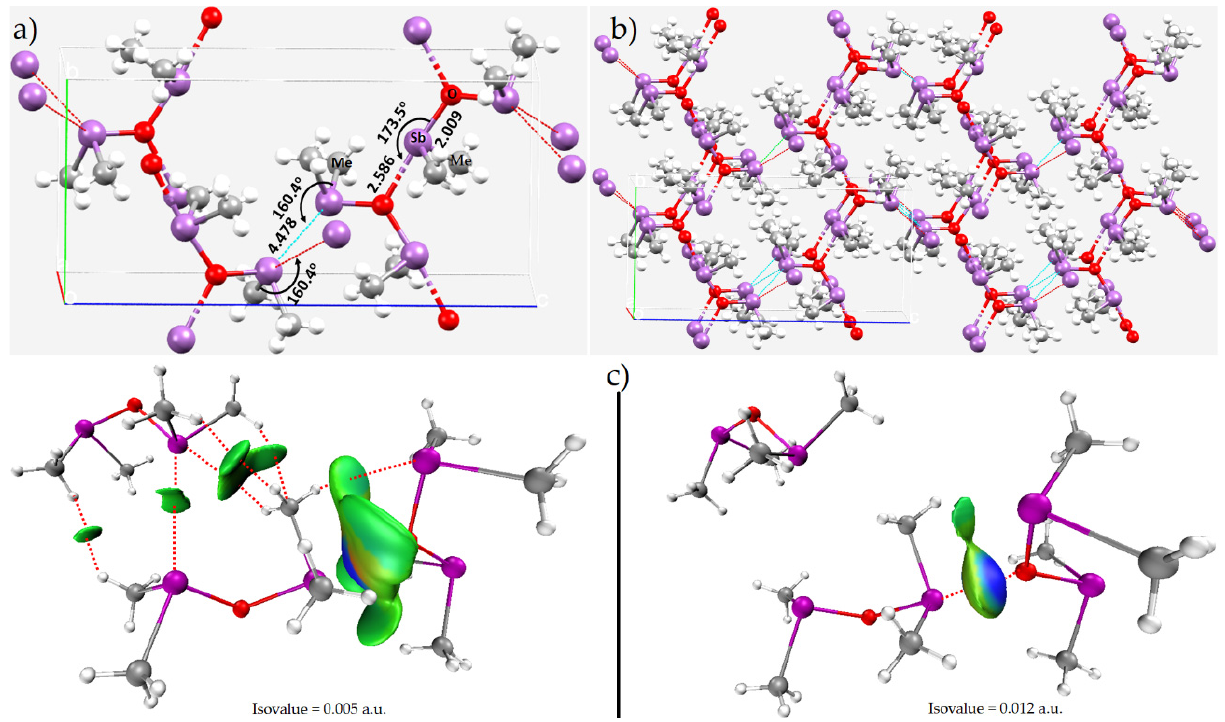
Figure 13. ( a ) Selected intermolecular bonding interactions in the crystal structure of bis(dimethylstibanyl)oxane, ((CH 3 ) 2 Sb) 2 O, CSD ref. code MELNAS. ( b ) The 2 × 2 extended structure of the unit-cell of the crystal, showing the Sb···O and Sb···Sb intermolecular contacts. ( c ) The IGM- δ g isosurface plots between ((CH 3 ) 2 Sb) 2 O entities in the crystal, illustrating the possibility of various intermolecular interactions that appear at low isovalues. Selected bond lengths and bond angles are in Å and degree, respectively. Contacts between atoms are shown as dotted lines in red or cyan. Atom color: Sb – purple; O – red; C – gray; H – white-gray.